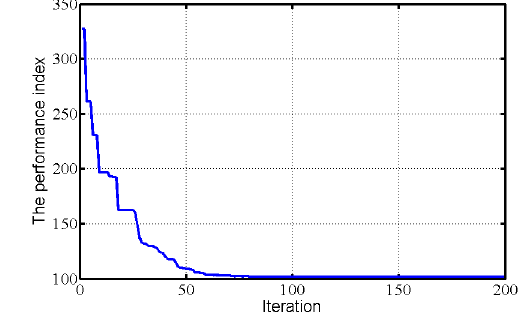
Figure 17. Evolutionary curve of the performance index for FOPID controller with operator.